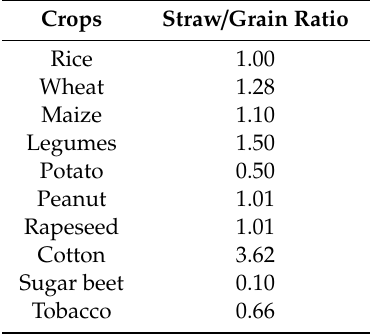
Table 1. The straw / grain ratio of di ff erent crop species